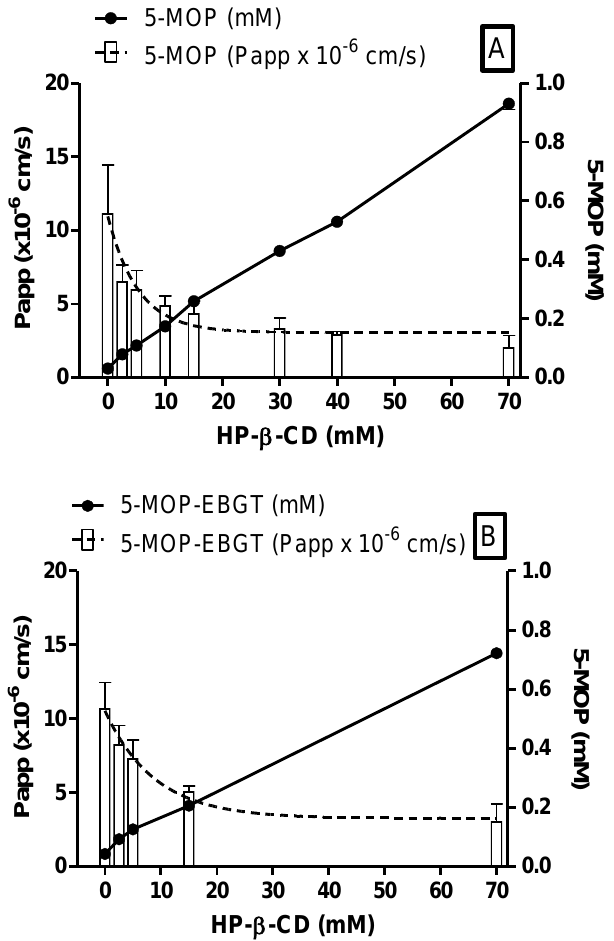
Figure 10. Ex vivo P app and solubility of 5-MOP standard ( A ) and 5-MOP EBGT marker ( B ) as a function of increasing HP- β -CD concentration. P app shown as mean ± SD ( n = 6) and expressed as × 10 – 6 cm/s; solubility shown as mean ± SD ( n = 3) and expressed as